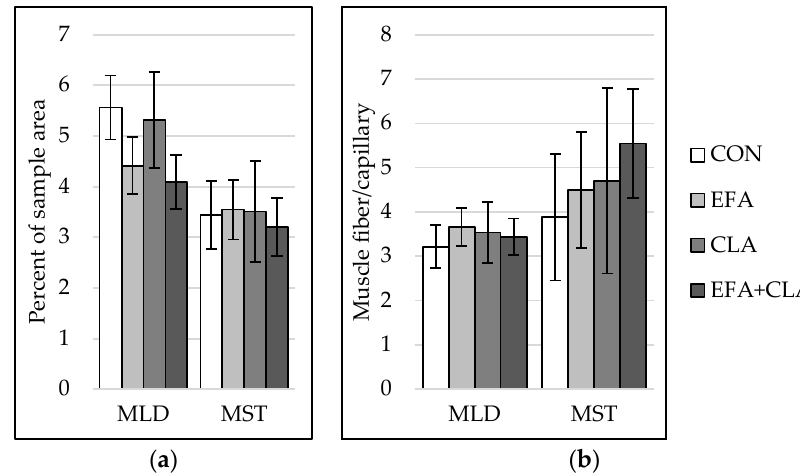
Figure 4. Capillarization in longissimus (MLD) and semitendinosus muscle (MST) of calves of four